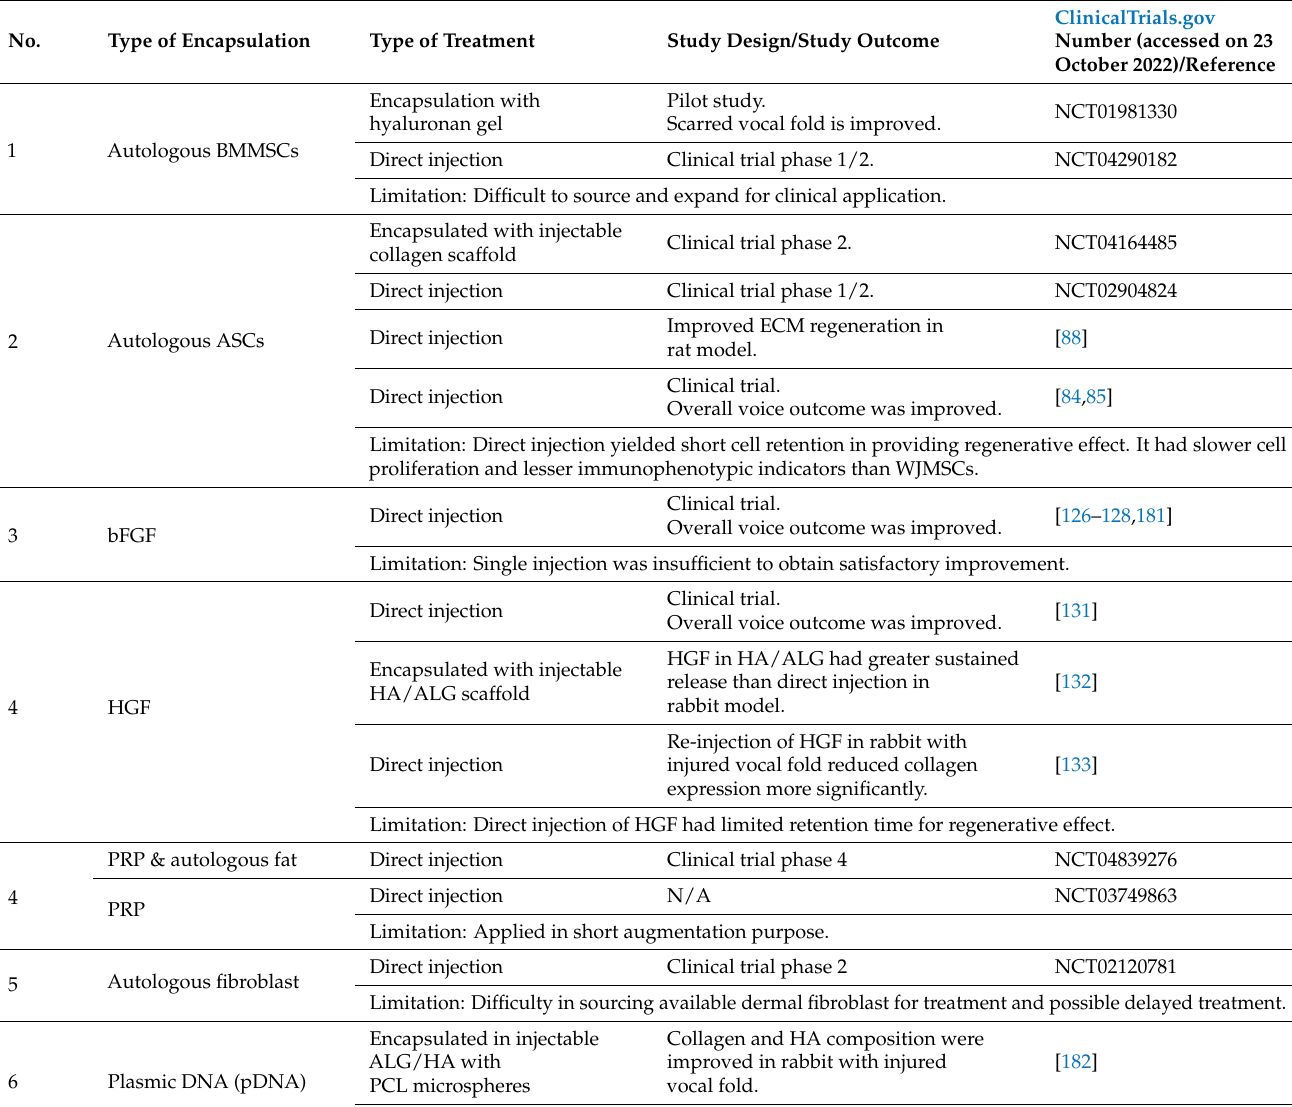
Table 1. Study outcome and limitation of recent studies on vocal fold injection for regeneration